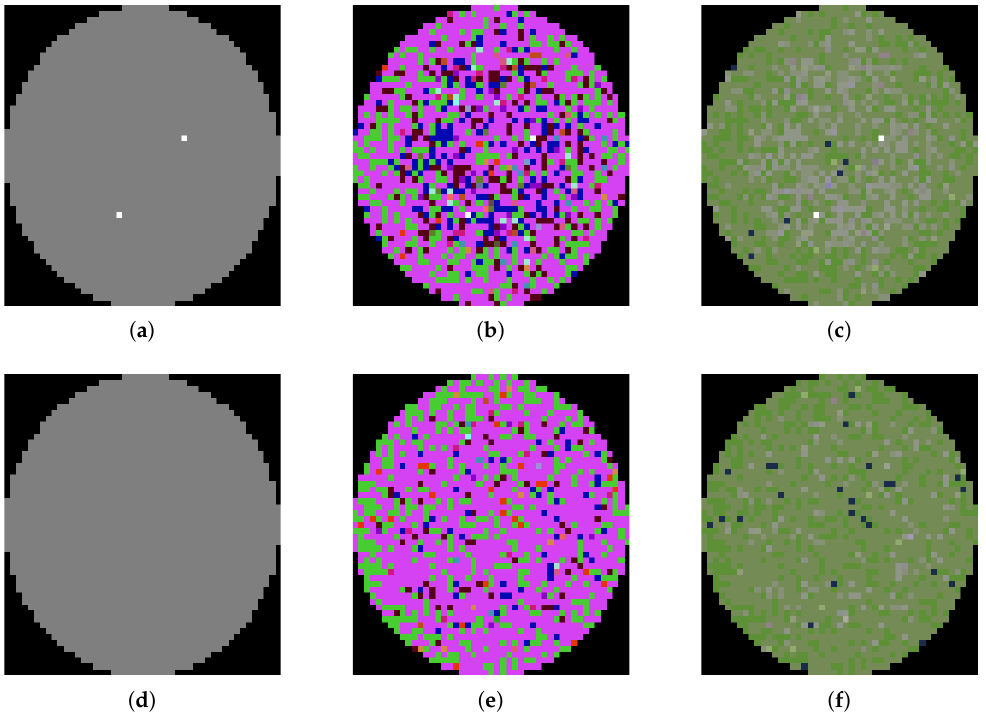
Figure 10. Examples of visualized novelty bin codes using Bin2Vec methodology (Binarization, Random RGB,